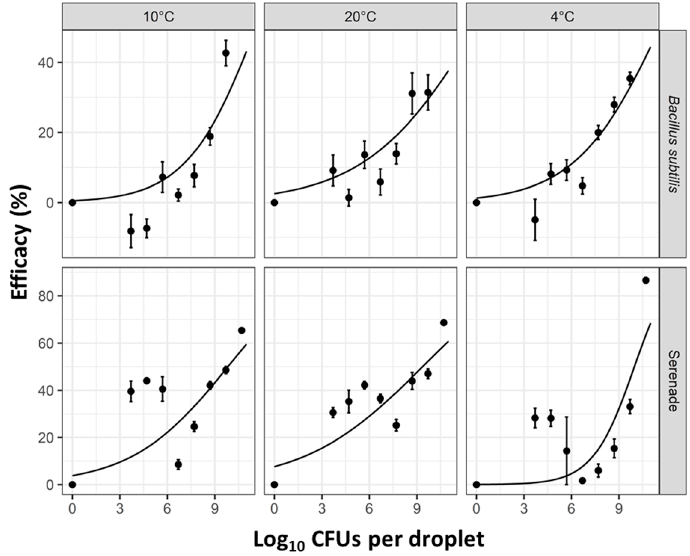
Figure 2. Efficacy from in vitro competition assays of B. subtilis and Serenade at tested inoculum doses inhibiting growth from a B. cinerea mycelial plug at 4, 10 and 20 °C; the bars represent one standard error and the curve is a fitted logistic model.